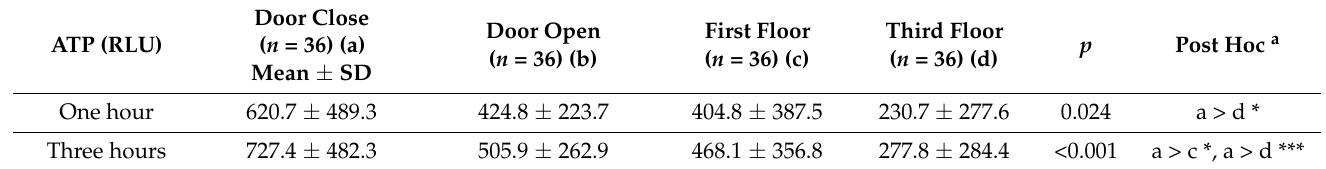
Figure 1. Values of ATP on two different plastic films, PVDC wrap and uncovered panel (null). ATP, adenosine triphosphate; RLU, relative light unit; PVDC, polyvinylidene chloride; * p < 0.05, ** p < 0.01, *** p < 0.001. Table 2. Comparison of ATP values on buttons of different locations ( n = 144).